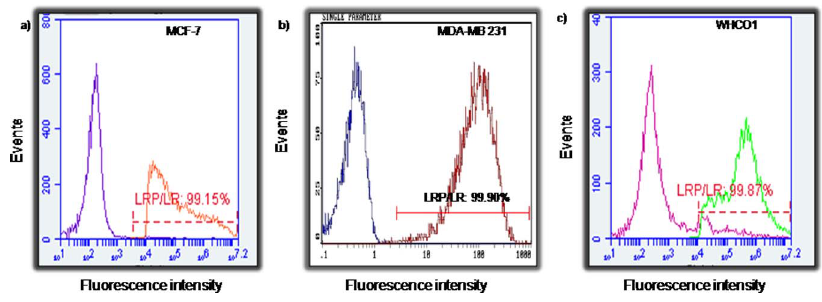
Figure 1. Detection of LRP/LR levels on the surface of oesophageal and breast cancer cells. FACS TM was performed using IgG1-iS18 antibody on (a) MCF-7, (b) MDA-MB 231 and (c) WHCO1 cells. The first curve represents the control labeled with goat anti-human IgG-coupled secondary antibody whilst the second curve represents cells labeled with both anti-LRP IgG1-iS18 primary and goat anti-human IgG-coupled secondary antibodies (30 m g/ml). Percentages were calculated using a linked marker from the point of overlap to the end of the second curve. Data are representative of three experiments carried out in triplicate using different cell cultures.